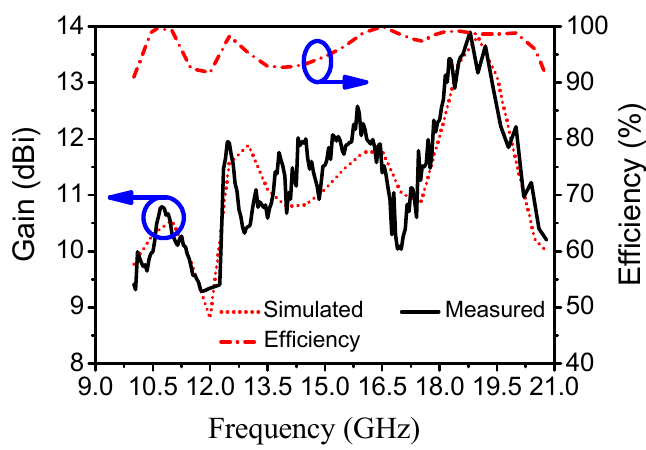
Figure 12. Simulated and measured radiation patterns of the proposed SWA: ( a ) E -plane at 11.0 GHz; ( b ) H -plane at 11.0 GHz; ( c ) E -plane at 16.15 GHz; ( d ) H -plane at 16.15 GHz; ( e ) E -plane at 20.0 GHz; ( f ) H -plane at 20.0 GHz.